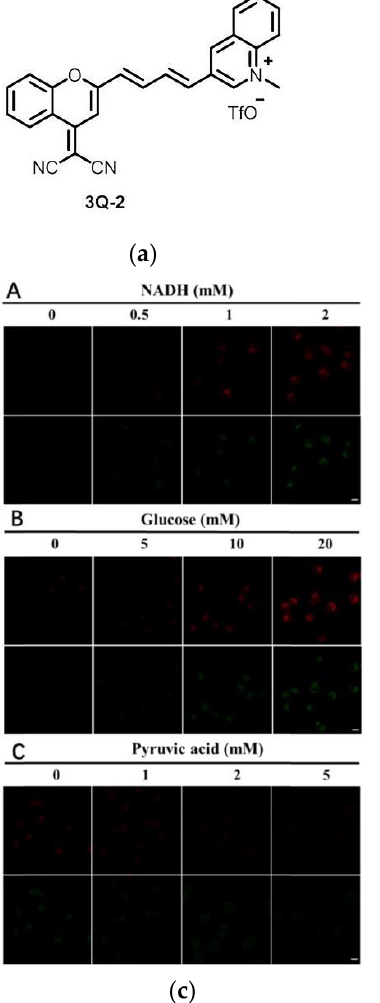
Figure 40. ( a ) The structure of probe 3Q-2; ( b ) Photoluminescence spectra of 3Q-2 incubating with NADH; ( c ) Confocal imaging of 3Q-2-stained PANC-1 cells. Reproduced with permission from [170]. Copyright 2021 Elsevier B.V.